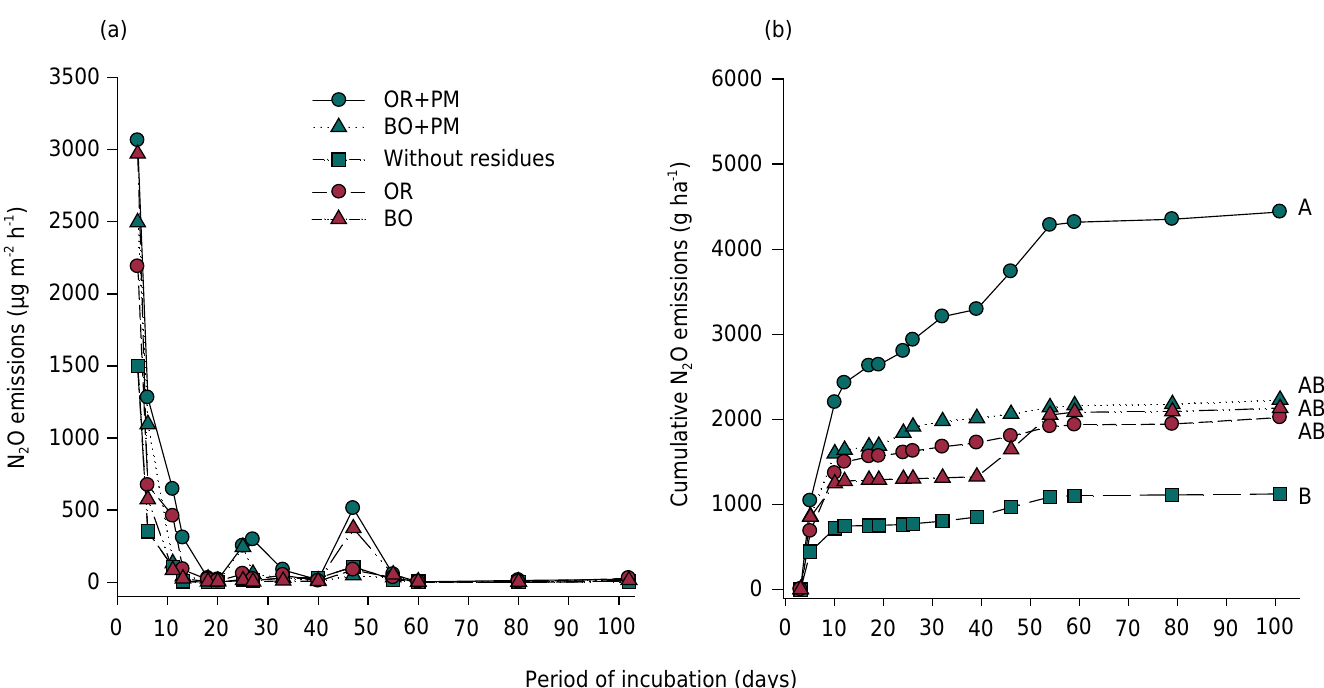
Figure 4. Fluxes (a) and cumulative emission (b) of N 2 O-N in soil with the addition of residues of oilseed radishes + poultry manure (OR+PM), black oats + poultry manure (BO+PM), oilseed radishes (OR), black oats (BO), and without residues. Means followed by the same letter are not statistically different from each other by the Tukey test at 5 % (n =